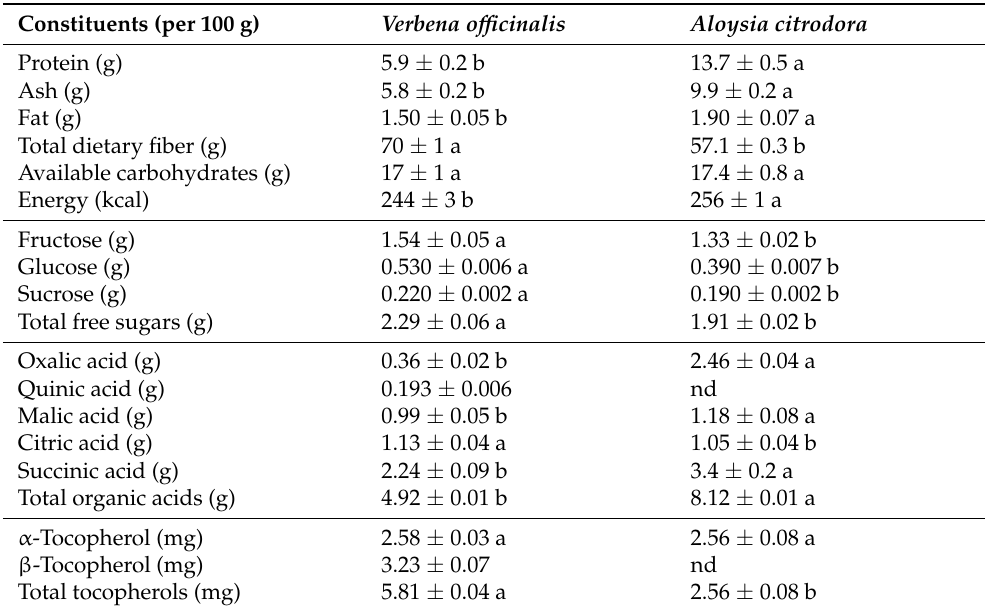
Table 2. Proximate composition, energy value, and organic acid and tocopherol composition of Verbena officinalis and Aloysia citrodora